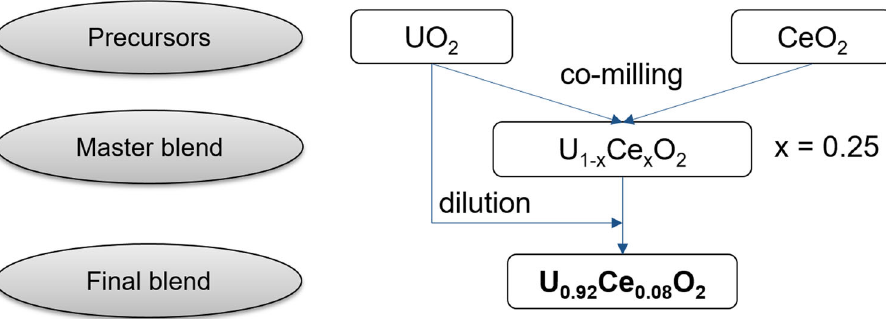
Fig. 12 Preparation of heterogeneous material. Powder metallurgy process used to prepare the heterogeneous U 0.92 Ce 0.08 O 2± δ